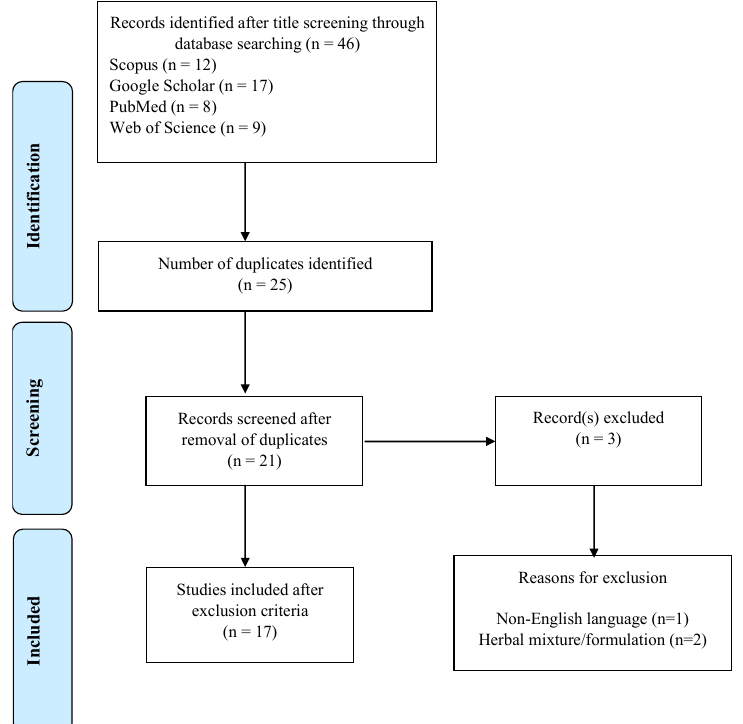
Figure 1. Flow chart used for systematic review.